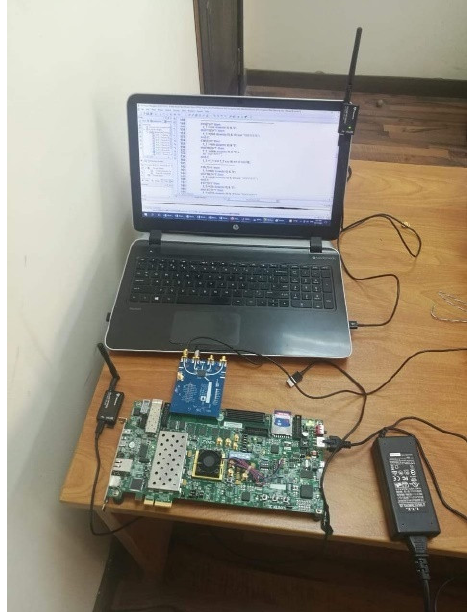
Figure 11. Hardware prototype demonstration.